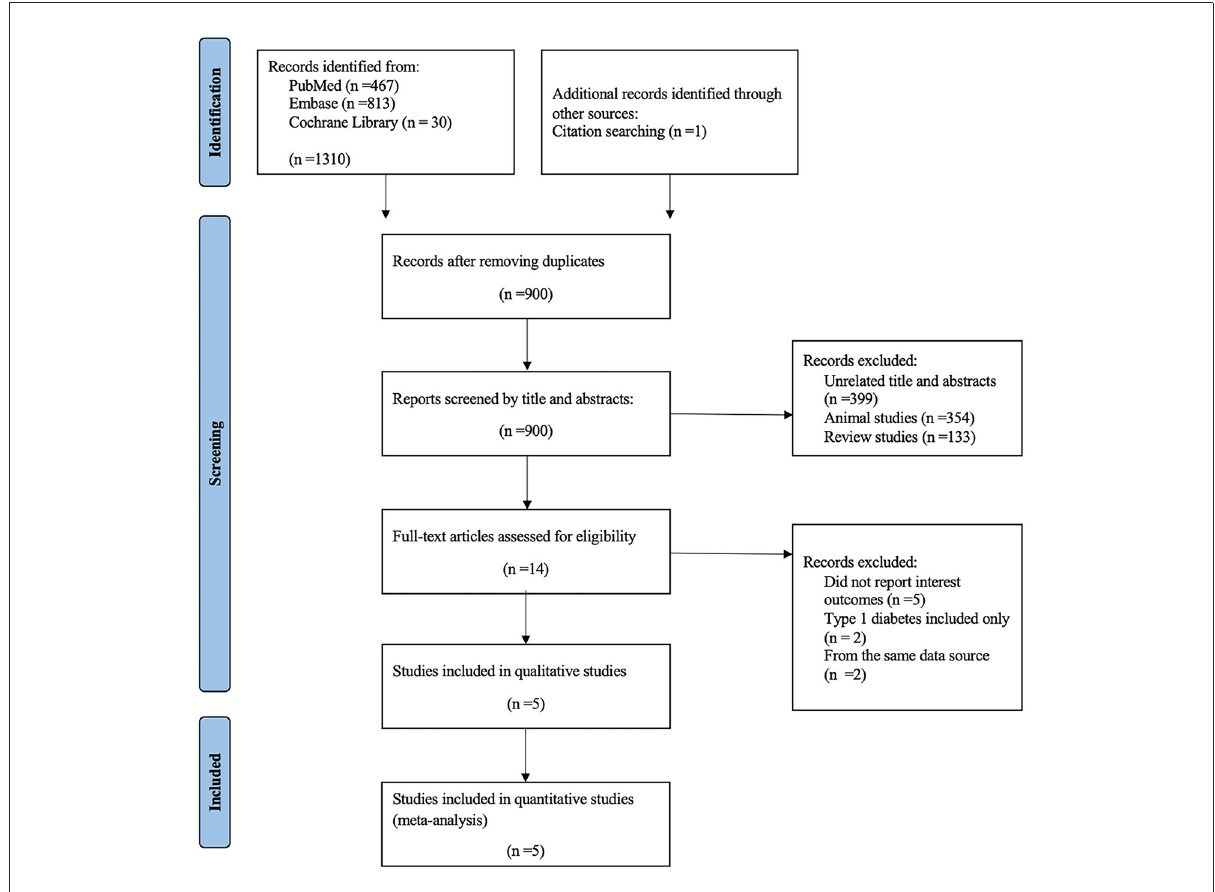
FIGURE1 PRISMA flowchart of study